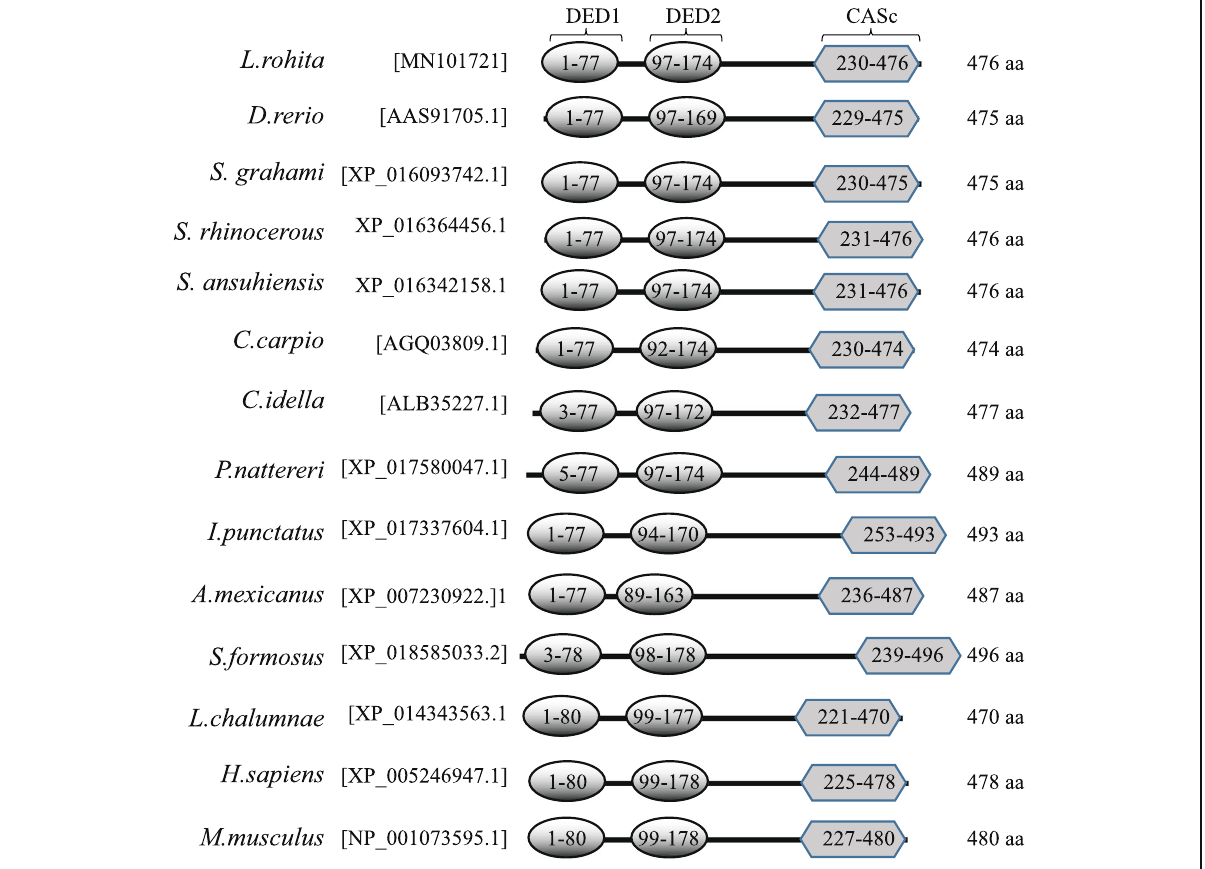
Fig. 3 Schematic representation of domains in fish, mouse, and human caspase-8. The domains in caspase-8 of various animals were predicted by SMART program. The death effector domains (DED1 and DED2) and the caspase, interleukin-1 β converting enzyme homolog (CASc) domain are shown as oval and hexagonal box at their respective positions